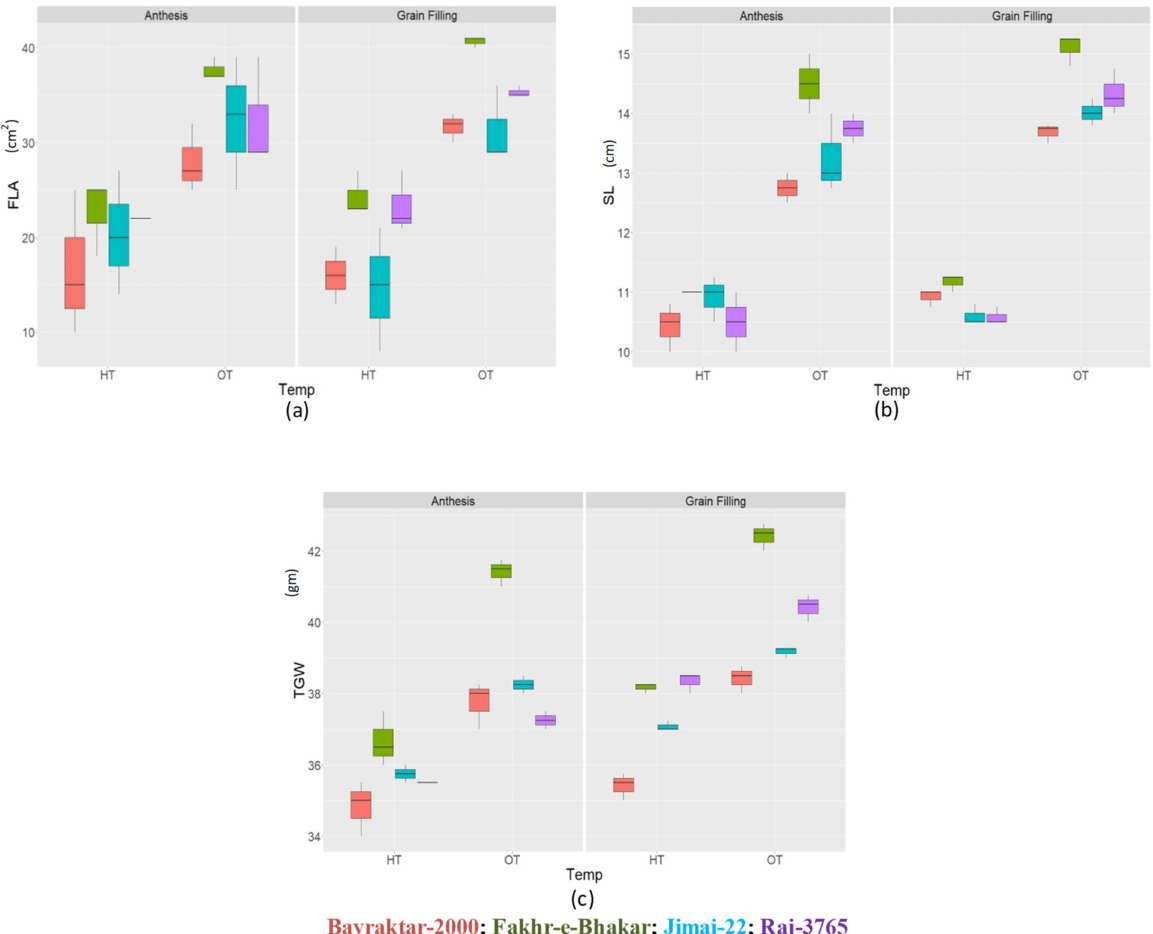
Figure 4. Effect of different regimes of temperature, optimum temperature (OT); high temperature (HT), on agronomic parameters of wheat genotypes during grain-filling and anthesis stages: ( a ). FLA, flag leaf area; ( b ). SL, spike length; ( c ). TGW, thousand grain weight. Values shown are mean estimates averaged at ripening during tri-replicate experiment at p ≤